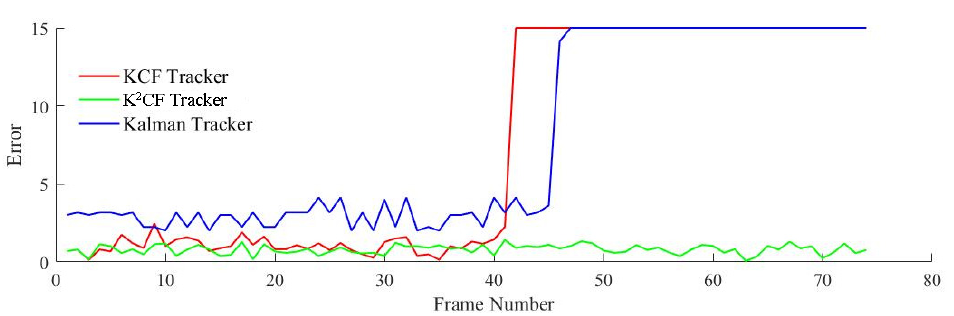
Figure 16. Detection error of uniform acceleration state.